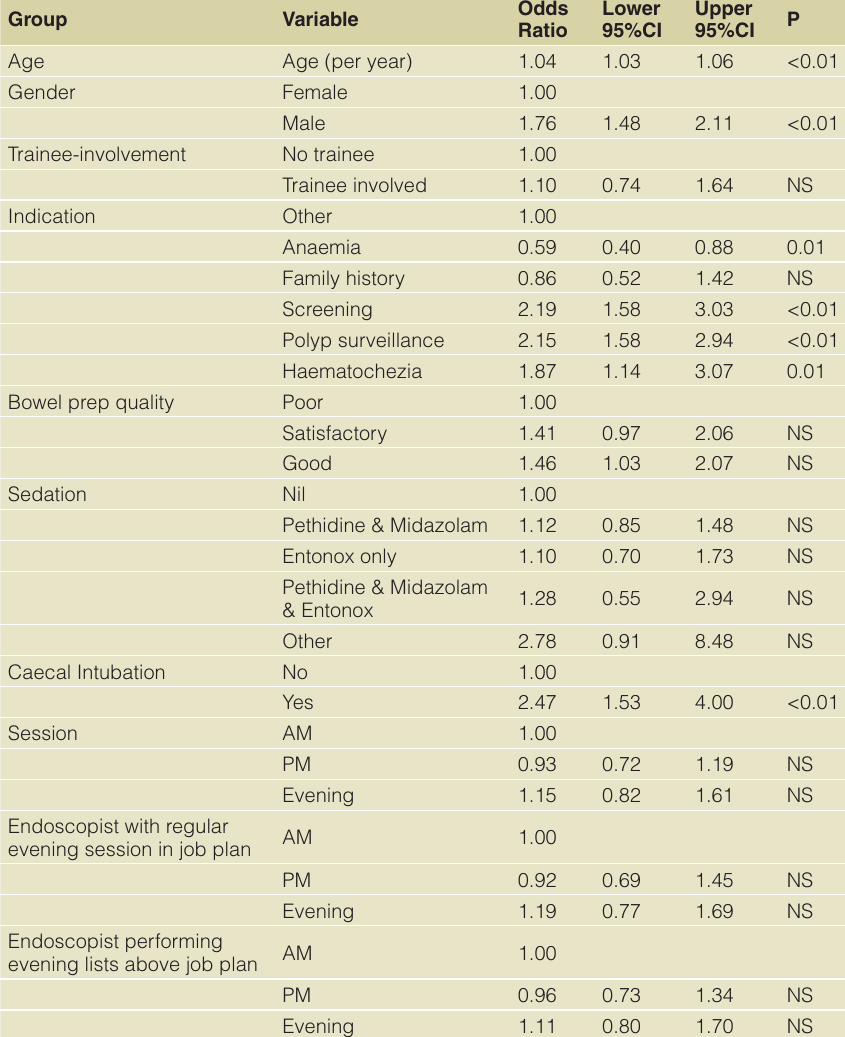
Table 2. Multivariate regression outputs showing the odds ratio and 95% confidence intervals for the detection of ‘any polyp’ for each independent variable. Results expresses as adjusted odds ratio for detection of any polyp. CI, confidence interval: NS, not